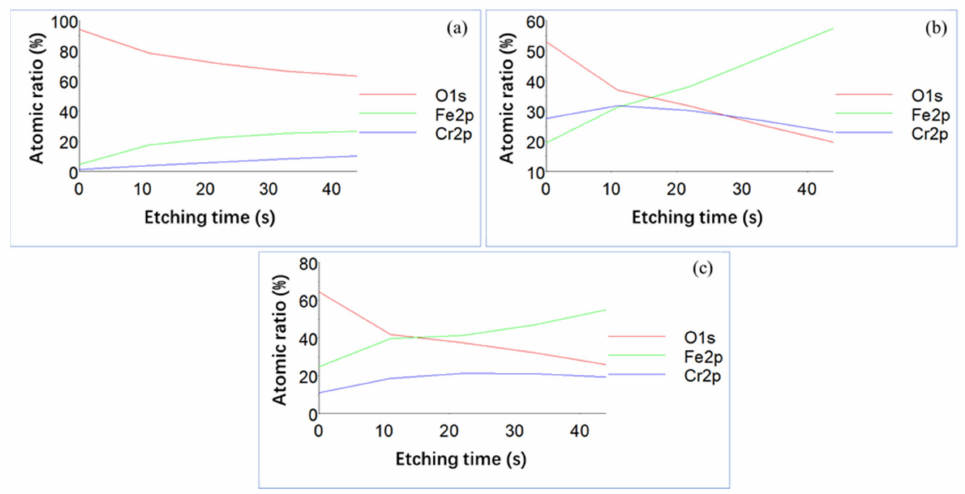
Figure 6. Depth profiles of Fe, Cr and O elements in the surface of original and treated SS316L by X-ray photoelectron spectroscopy (XPS). ( a ) original SS316L before potentiodynamic tests; ( b ) treated SS316L before potentiodynamic tests and ( c ) treated SS316L after potentiodynamic